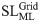
The RMSE versus the time needed for the estimation of the three parameters of the Ricker model (see Eq 1).The RMSE and time are based on 100 test data sets with Tobs = 1000. The three colors represent the three parameters (blue for r, red for σ and yellow for ϕ). Solid lines represent the SLOrig approach, dashed lines the SLMLGrid approach (using only nearest neighbors), and dotted lines the SLMLSVM approach (using interpolation). The stars and the dots represent the time needed for the SLMLGrid and the SLMLSVM estimation, respectively. The estimates for SLOrig are posterior means, based on the second half of the finished MCMC iterations. The time of the prepaid method shown in this picture does not include the creation of the prepaid grid, but only the time needed for any researcher to estimate the parameters once a prepaid grid is available.